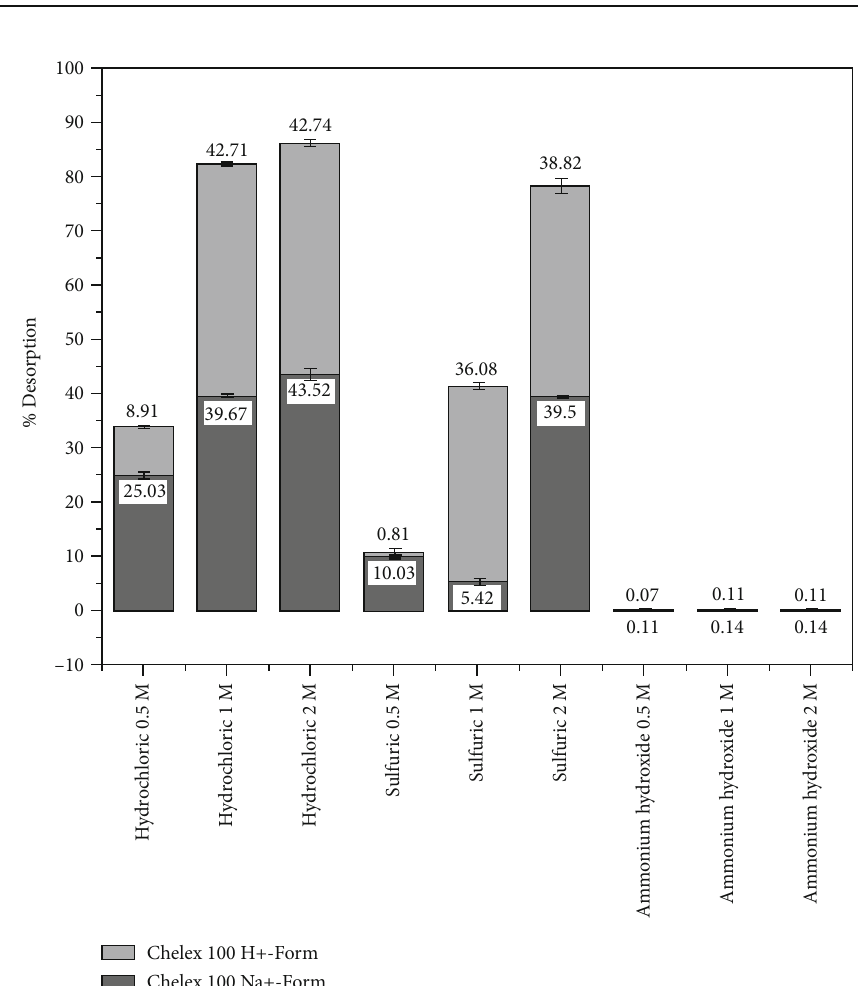
Figure 8: Desorption e ffi ciency of copper (II) ions loaded onto Chelex 100 chelating resin at the di ff erences of concentrations used of desorbed